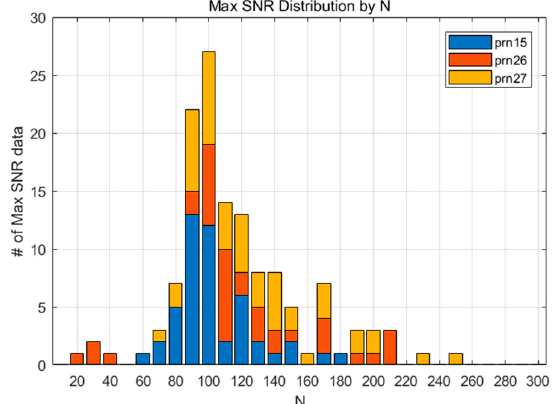
Figure 5. The maximum SNR distribution according to various values of N (MND) .